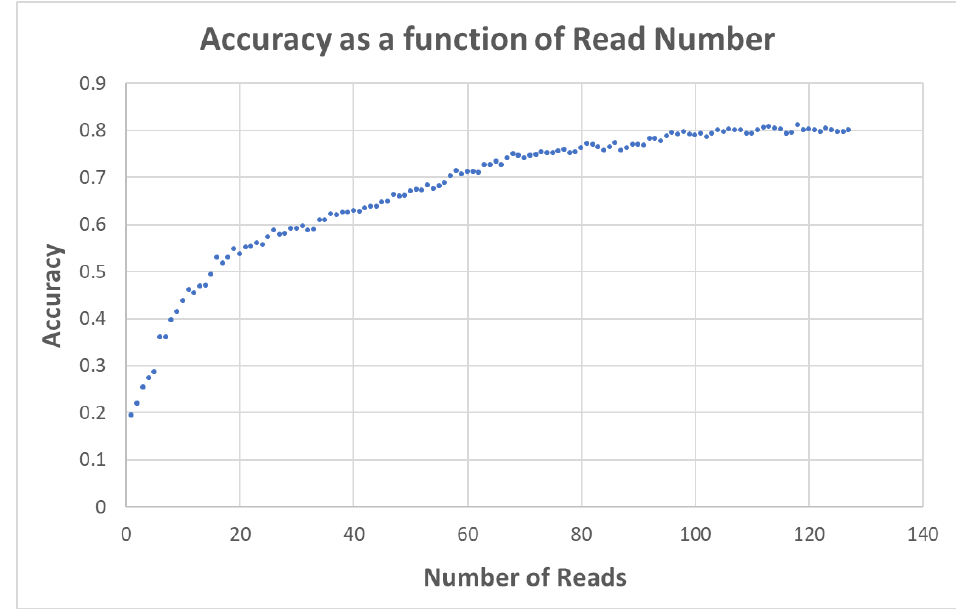
Figure 6. Testing results increasing the number of reads (where each read of the input image is run along with a set of control signals) appears to increase prediction accuracy until about one hundred reads, beyond which the performance appears to stabilize.